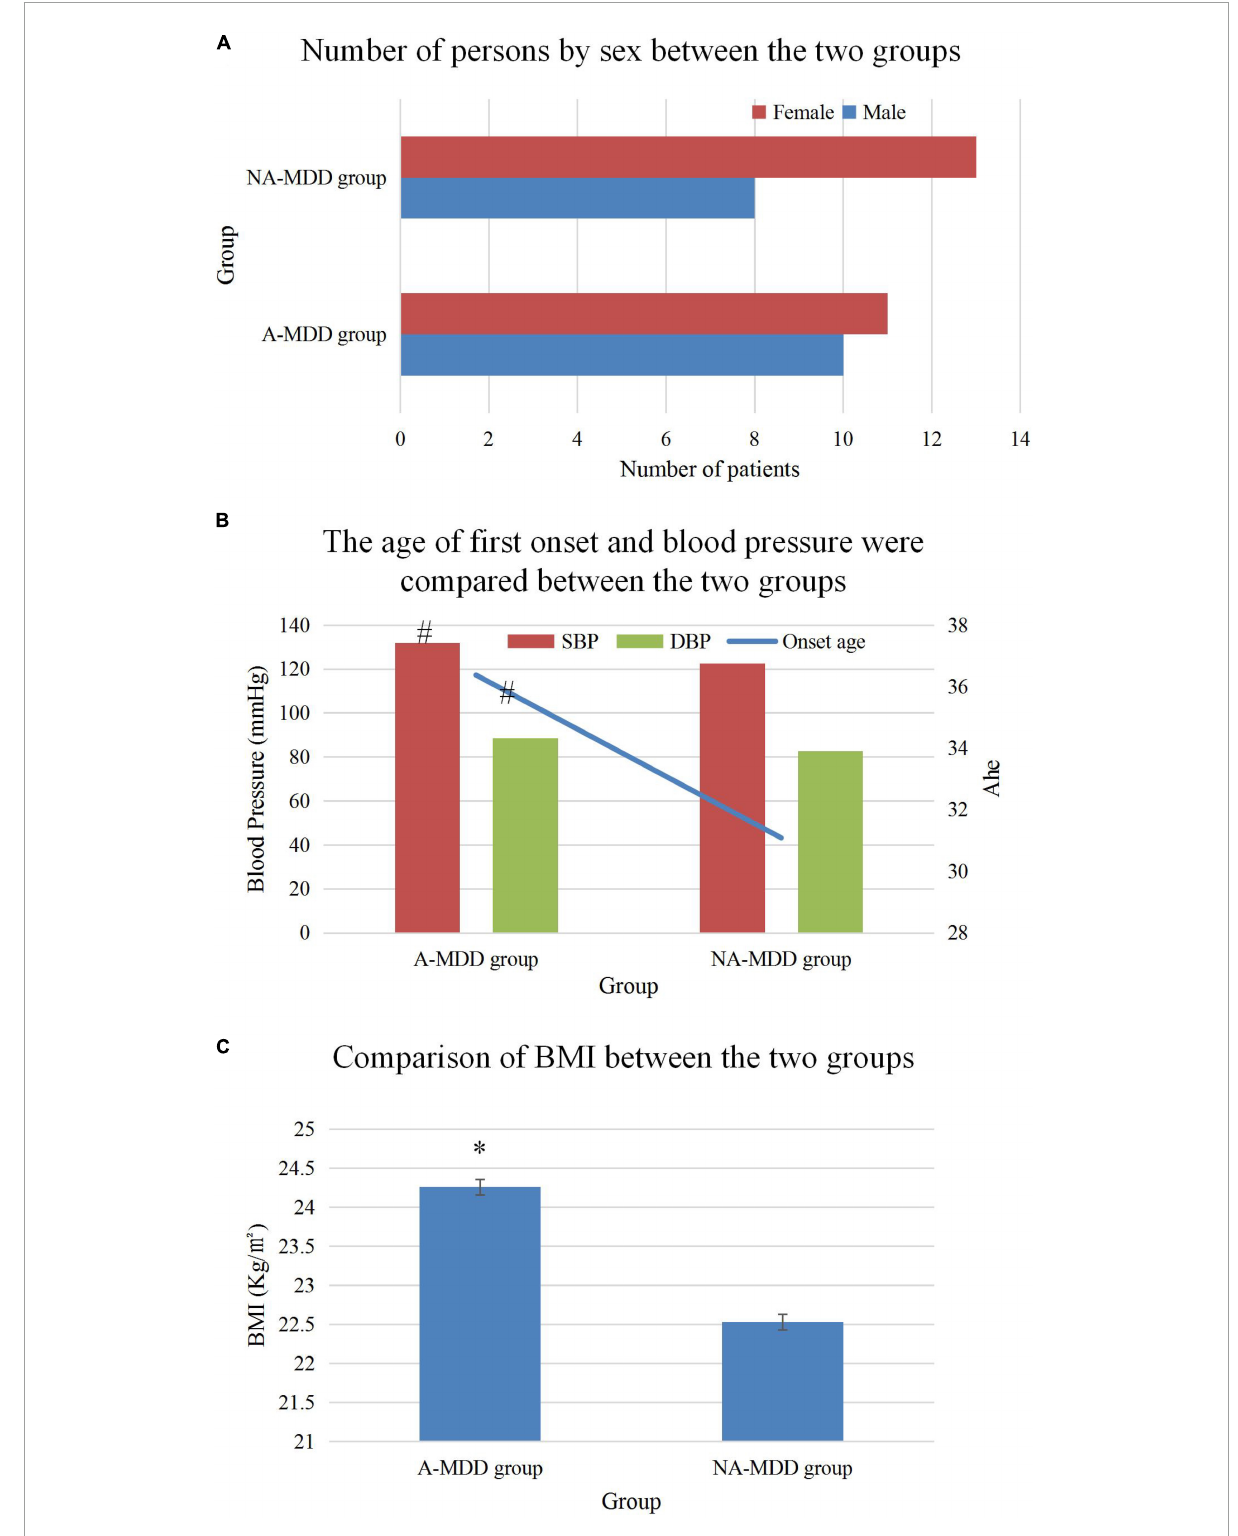
FIGURE4 Comparison of general data of patients. (A) Was the comparison of the number of men and women, (B) showed the comparison of the first onset age and blood pressure, and (C) illustrated the comparison of the BMI value. ∗ and # Represented P < 0.05 and P < 0.01 compared with the NA-MDD group,